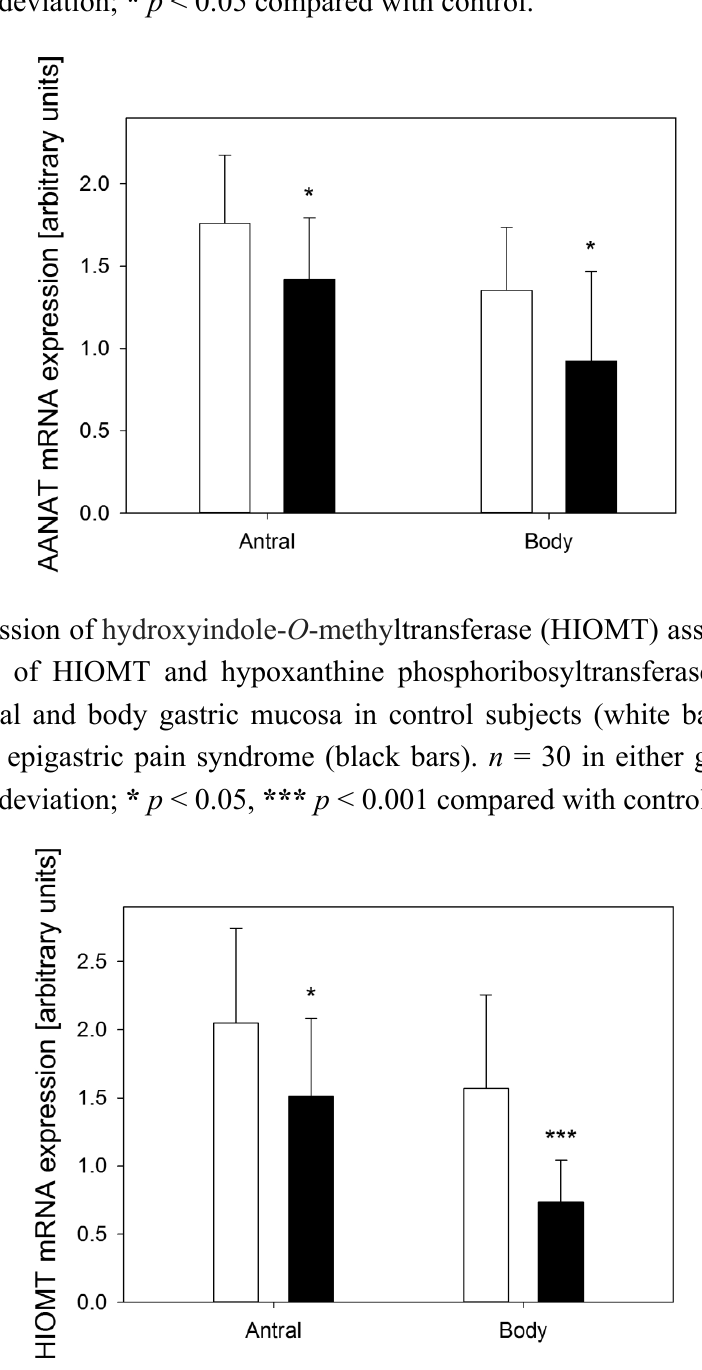
Figure 1. Expression of arylalkylamine- N -acetyltransferase (AANAT) assessed as relative quantity of mRNA of AANAT hypoxanthine phosphoribosyltransferase (reference) by RT-PCR in antral and body gastric mucosa in control subjects (white bars) and patients with continuous epigastric pain syndrome (black bars). n = 30 in either group; error bars denote standard deviation; * p < 0.05 compared with control.